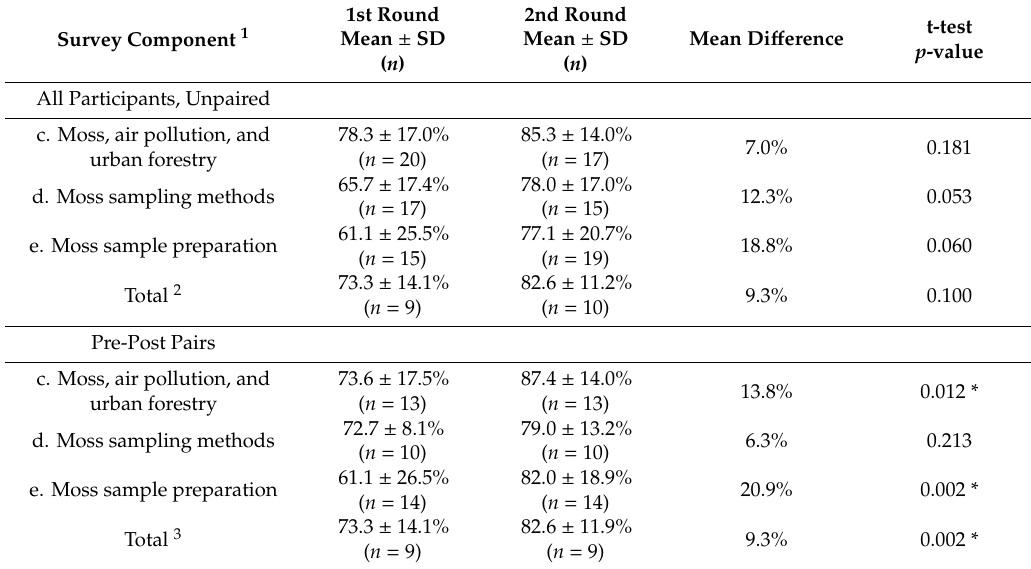
Table 5. Scores on test-style survey components in the 1st and 2nd rounds of administration, stratified by unpaired and paired